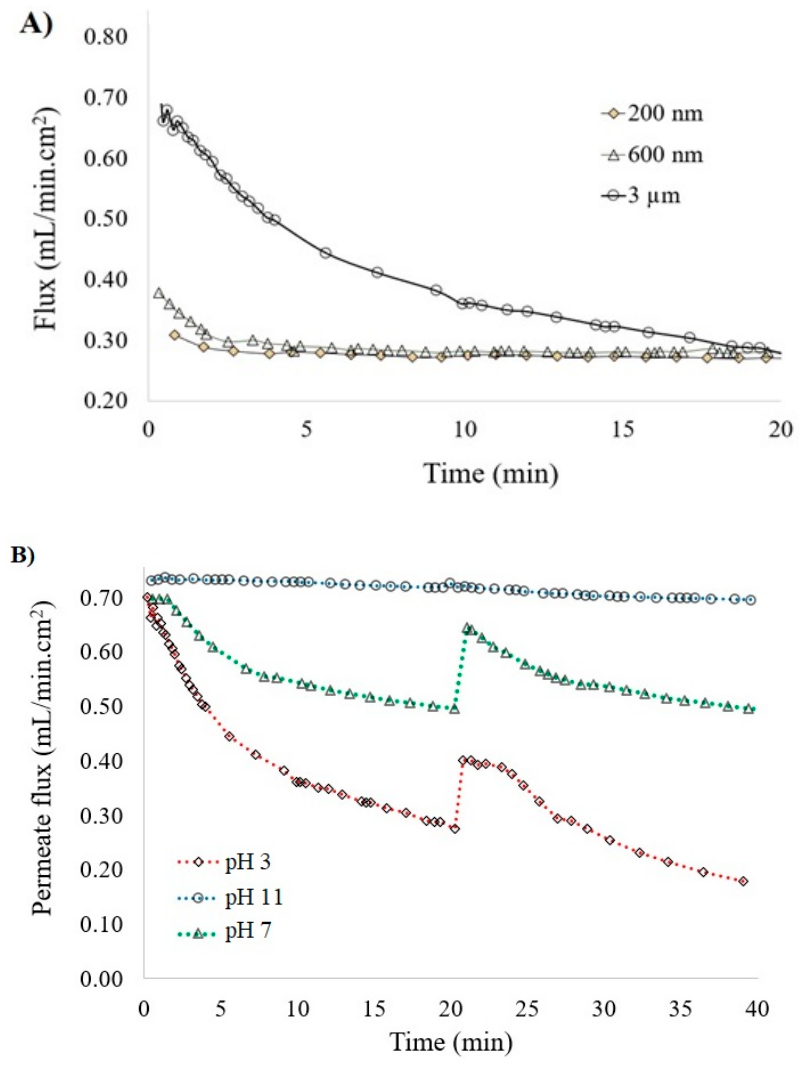
Figure 4. ( A ) Comparison of membrane filtration flux of OS bio-adsorbent from treated TW using tubular ceramic (Al 2 O 3 ) membrane with pore sizes of 200 and 600 nm, and 3 µ m. ( B ) Flux variation with pH (3, 7, and 11) across the 3 µ m pore size membrane and after backwashing (20 min) with distilled water.